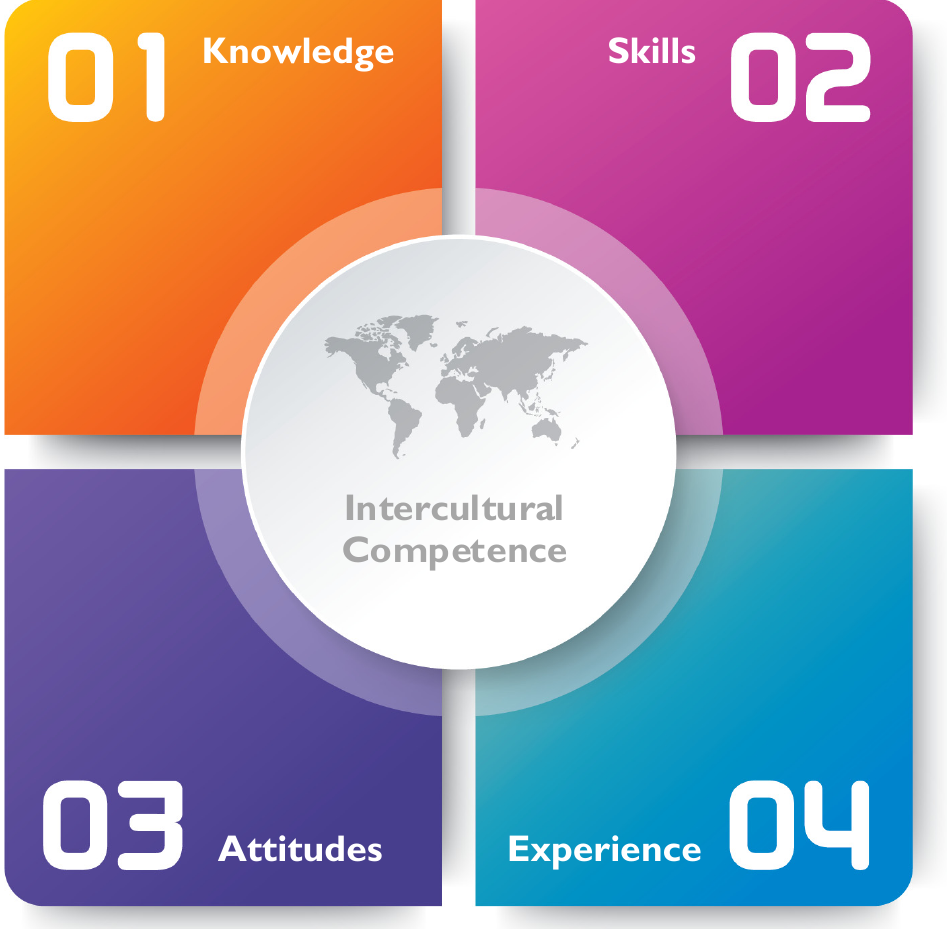
Figure 5. Based on Deardorff (2006), the Nelson Quadrilateral conceptualises four constituent elements of intercultural competence: knowledge, skills, attitudes, and experience.